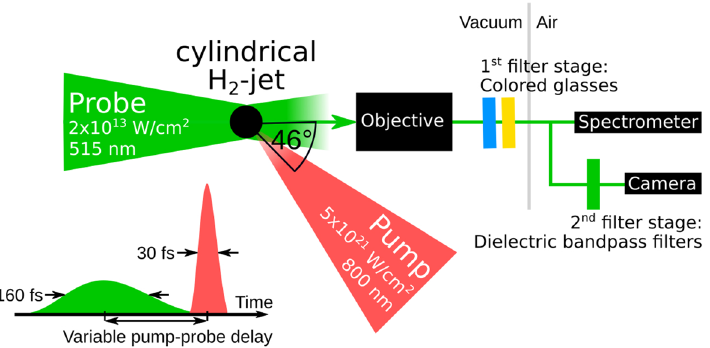
Figure 1. Top view of the experimental setup including a cylindrical cryogenic hydrogen jet target (black circle), pump laser (red beam), off-harmonic optical probe laser (green beam) as backlighter, imaging beamline with microscope objective (numerical aperture 0.28, working distance 80mm ) and spectral filters, spectrometer and CMOS-camera for